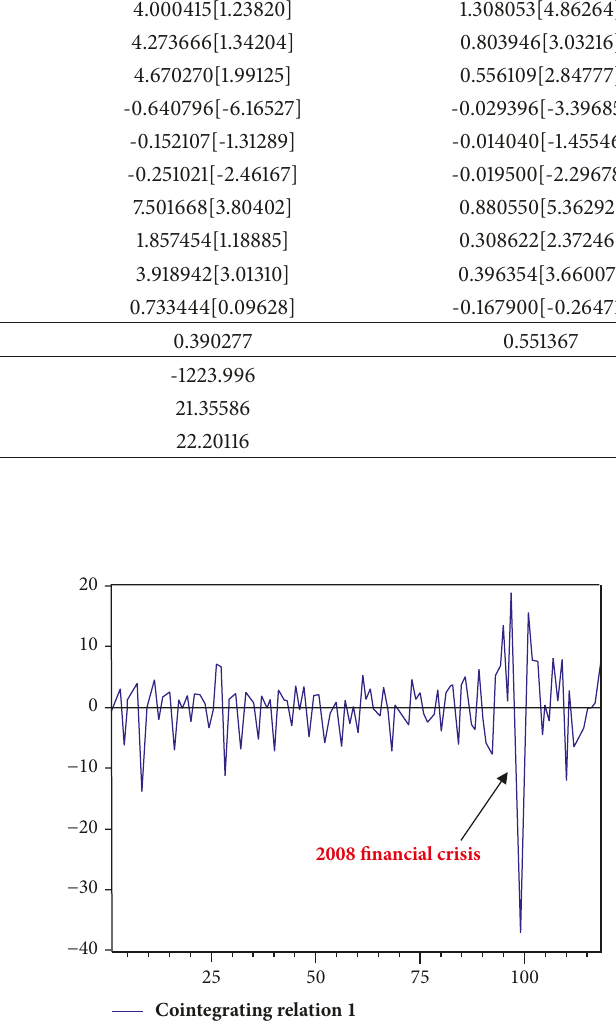
Figure 2: Cointegration relationship